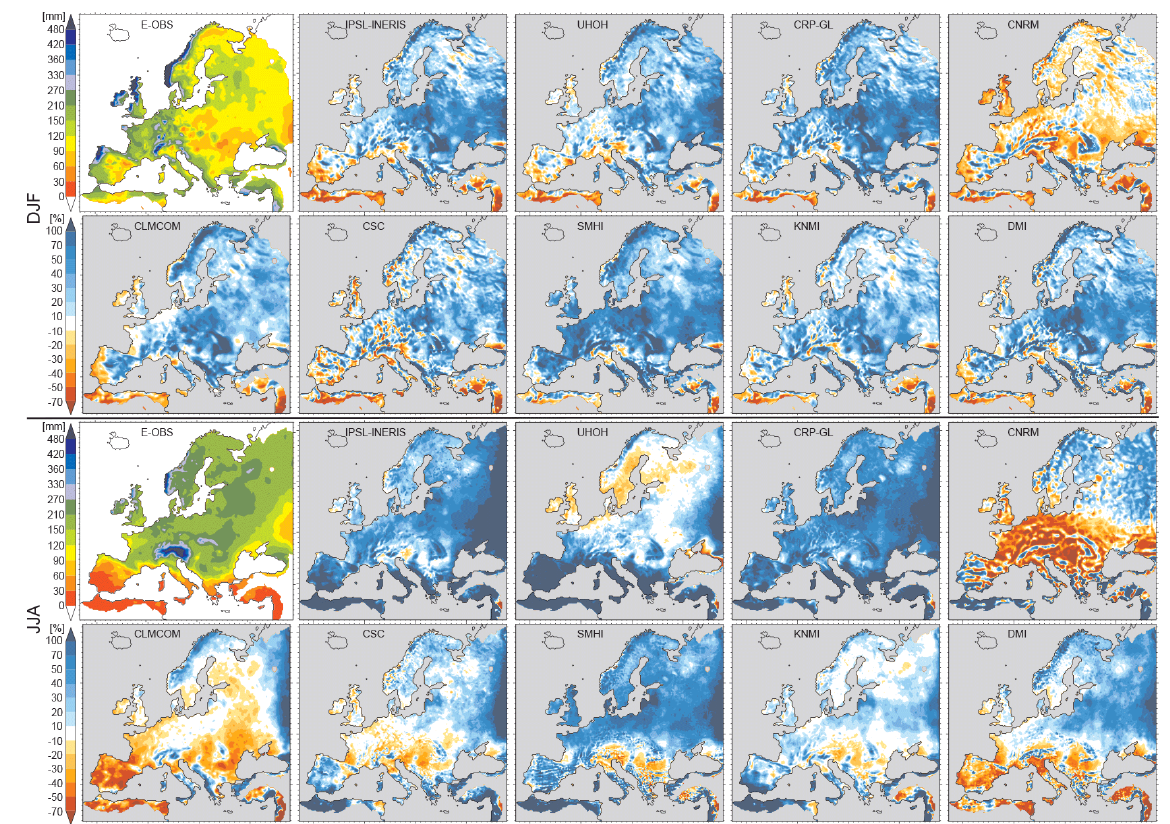
Figure 3. As Fig. 2 but for the mean relative seasonal precipitation bias (%). The upper-left panel of each section shows the horizontal pattern of mean seasonal precipitation as provided by the E-OBS reference (mmmonth − 1